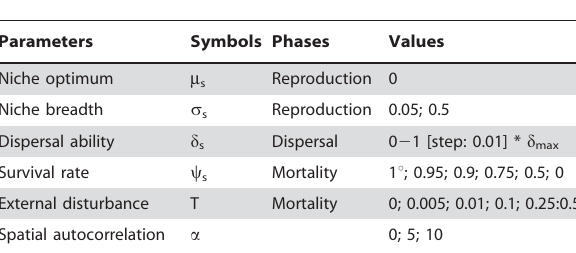
Table 1. Parameter values used for the